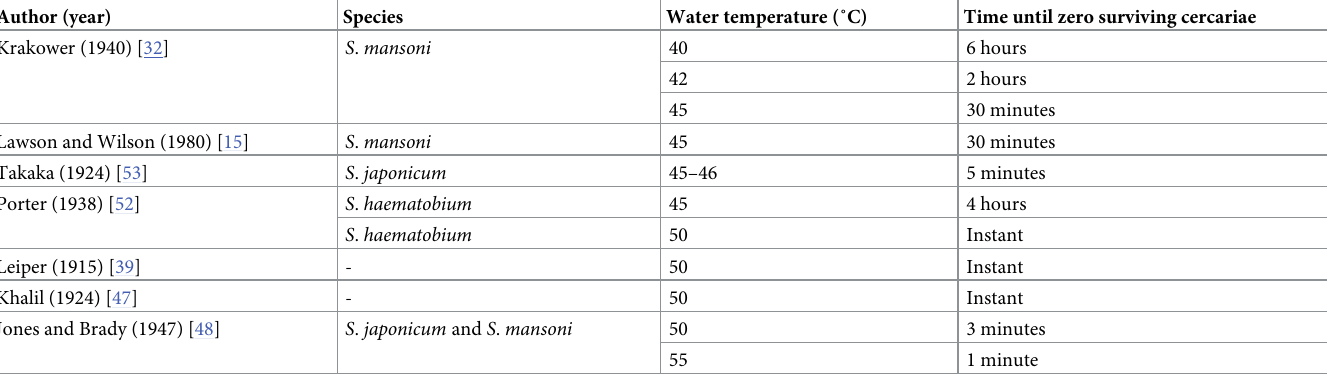
Table 3. Thermal death points for Schistosoma